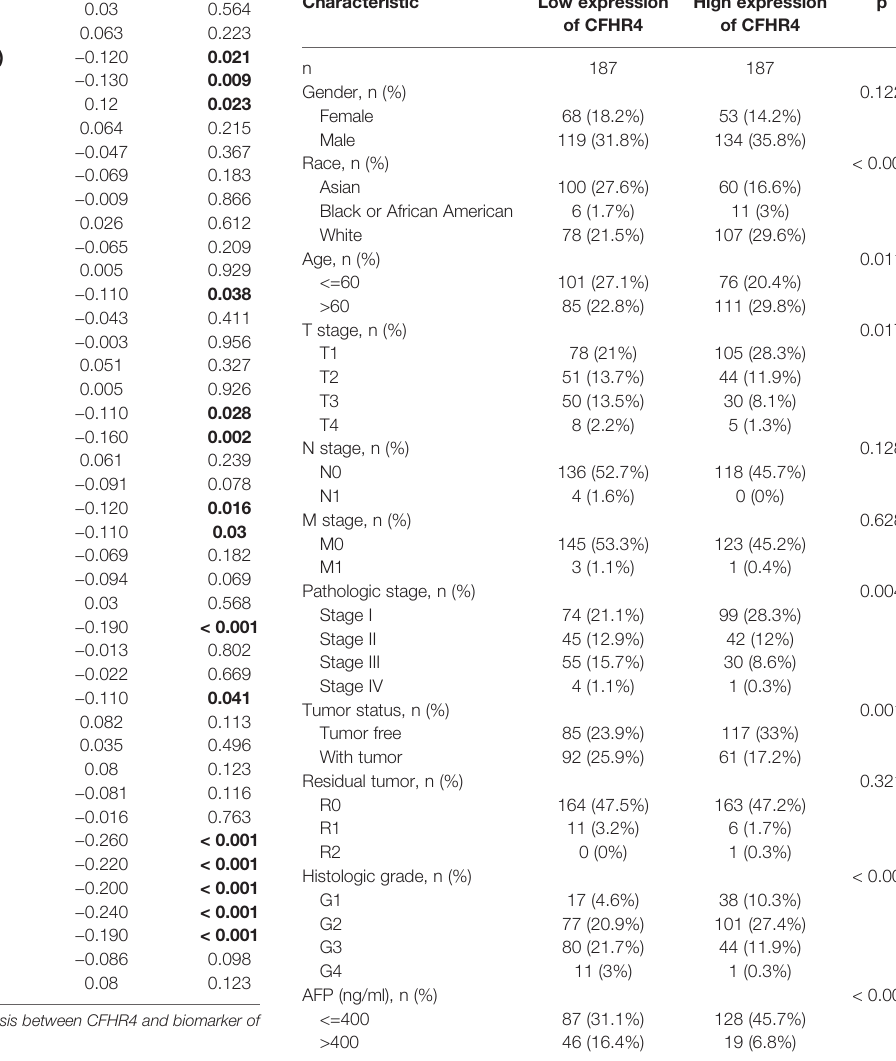
TABLE 2 | The correlations between clinicopathological variables and CFHR4